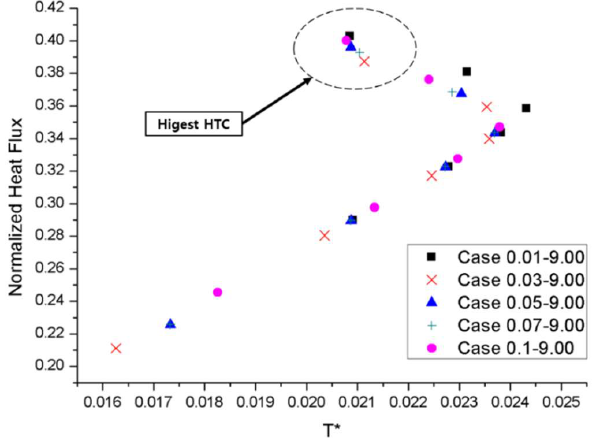
Figure 8. Boiling curves on a heat flux vs. superheat graph according to the pattern pitch 9.00 pattern ratio.